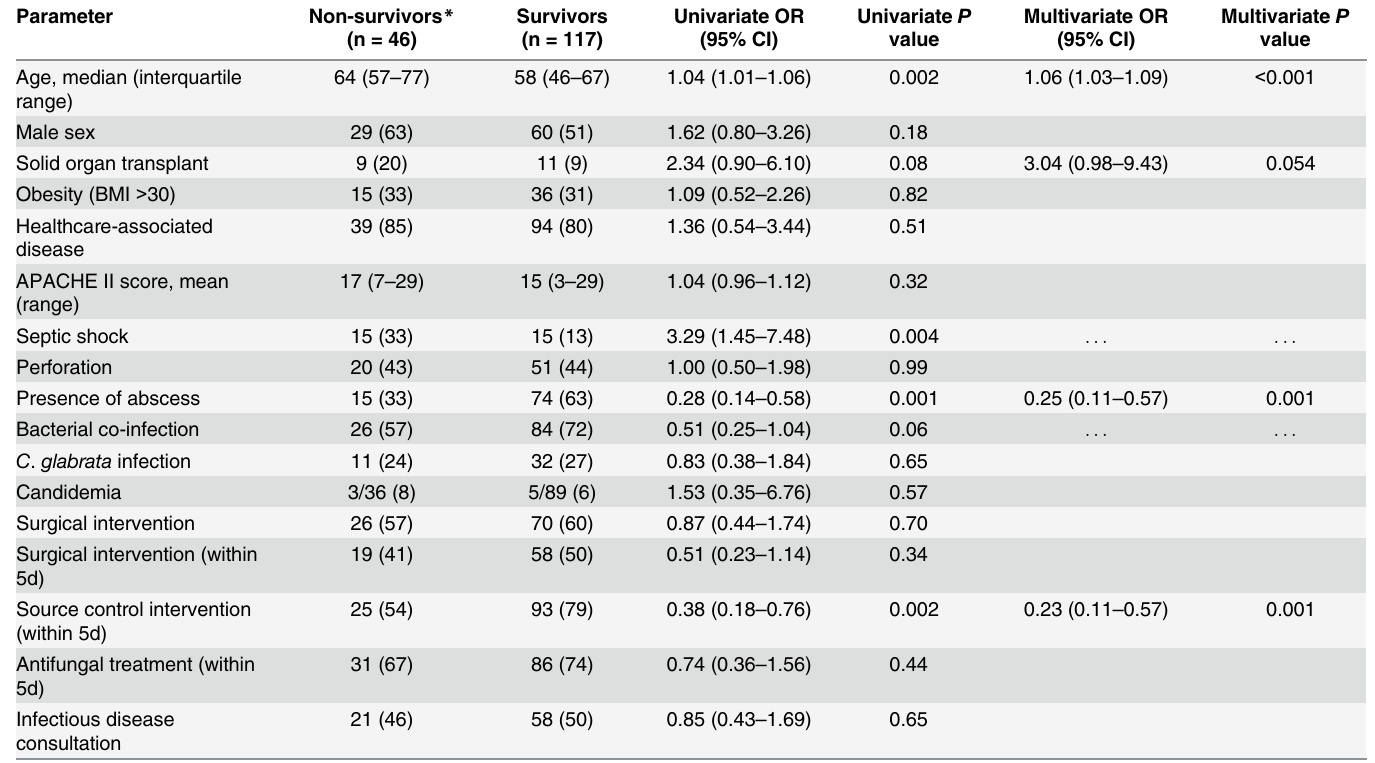
Table 4. Predictors of 100-day mortality for all subjects with